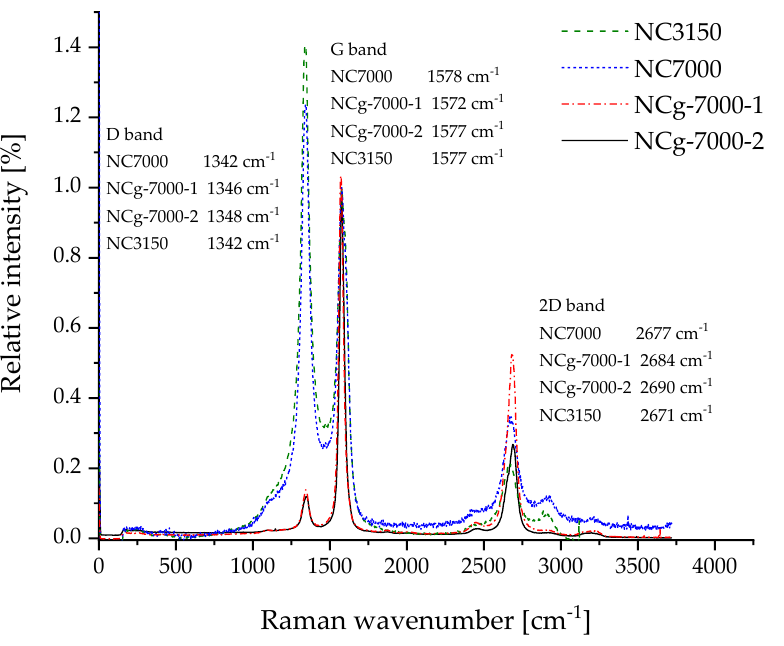
Figure 8. Raman spectra of NC3150, NC7000, NCg-7000-1, and NCg-7000-2, all normalized to the G-band.